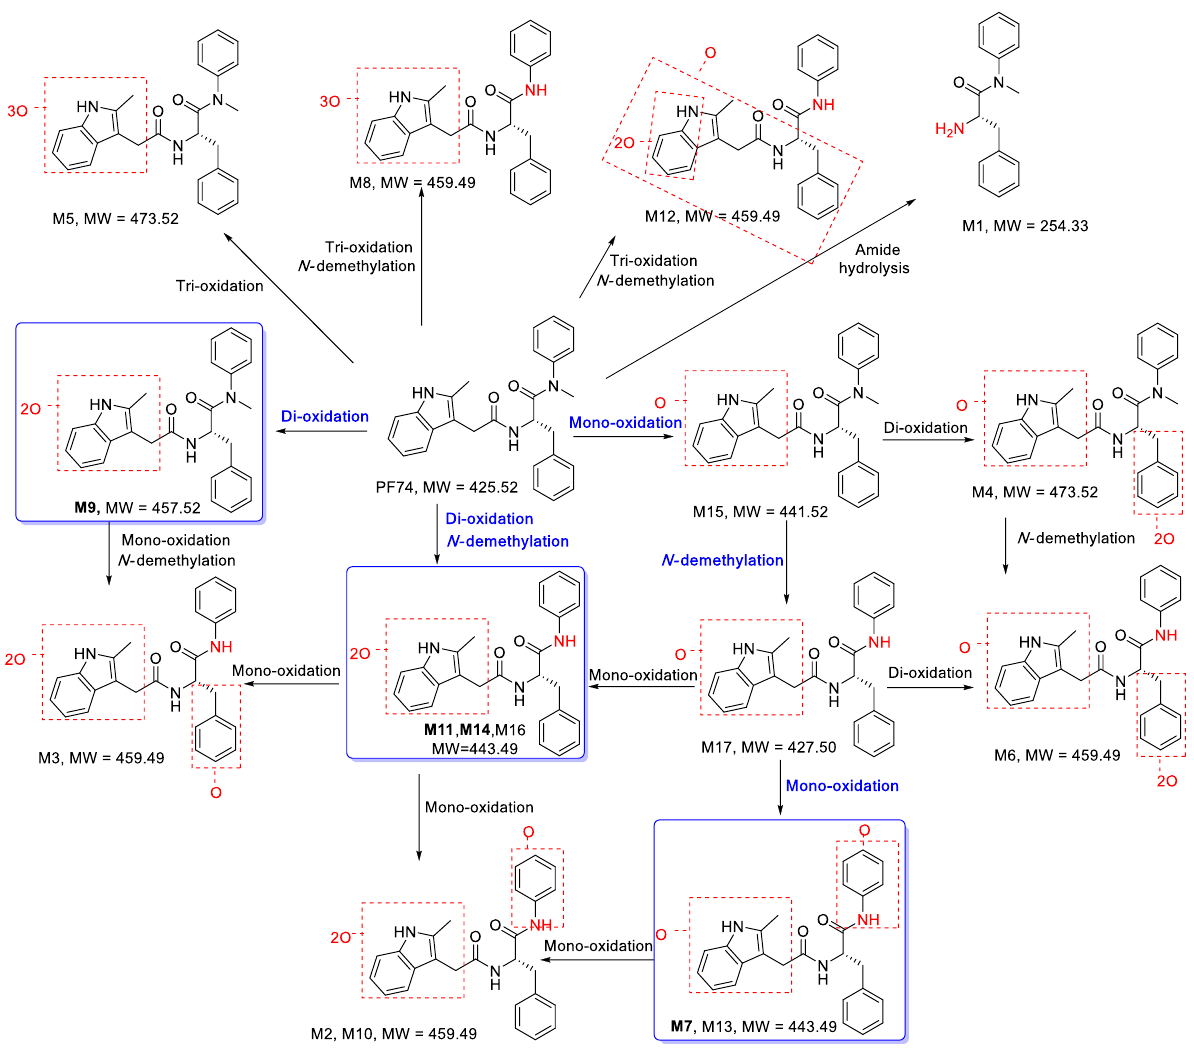
Figure 5. Proposed metabolic pathways of PF74 in HLMs. The main pathways are highlighted in blue.